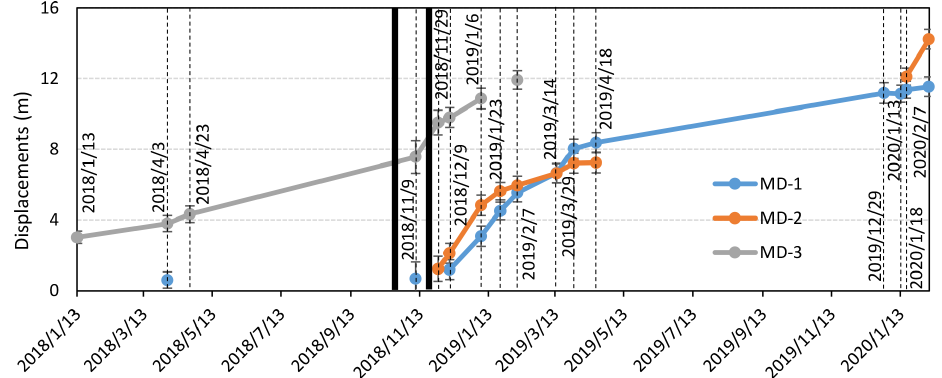
Figure 5. Cumulative displacements of three points (crosses in Fig. 4) on three slopes near Mindu village (two black vertical lines indicate the occurrence date of the Baige outburst floods in late October and November 2018). There were no displacement data for MD-2